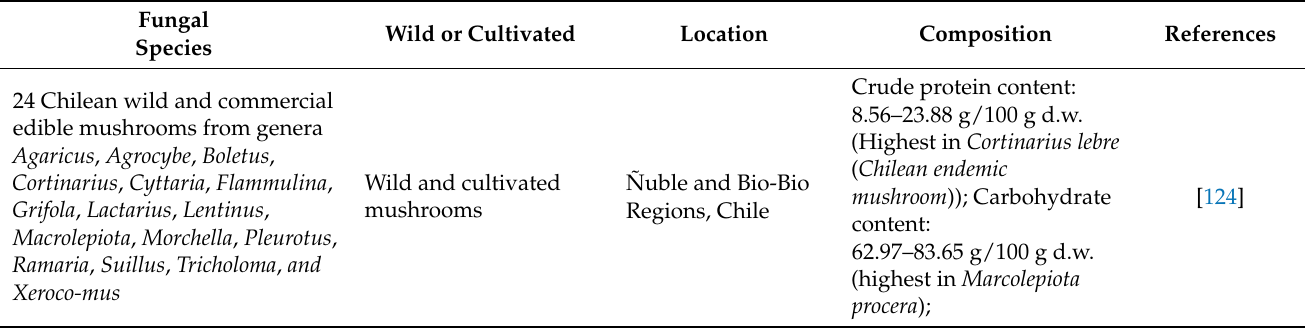
Table 2. List of studies on protein and carbohydrate contents in edible fungi from different geographical locations from